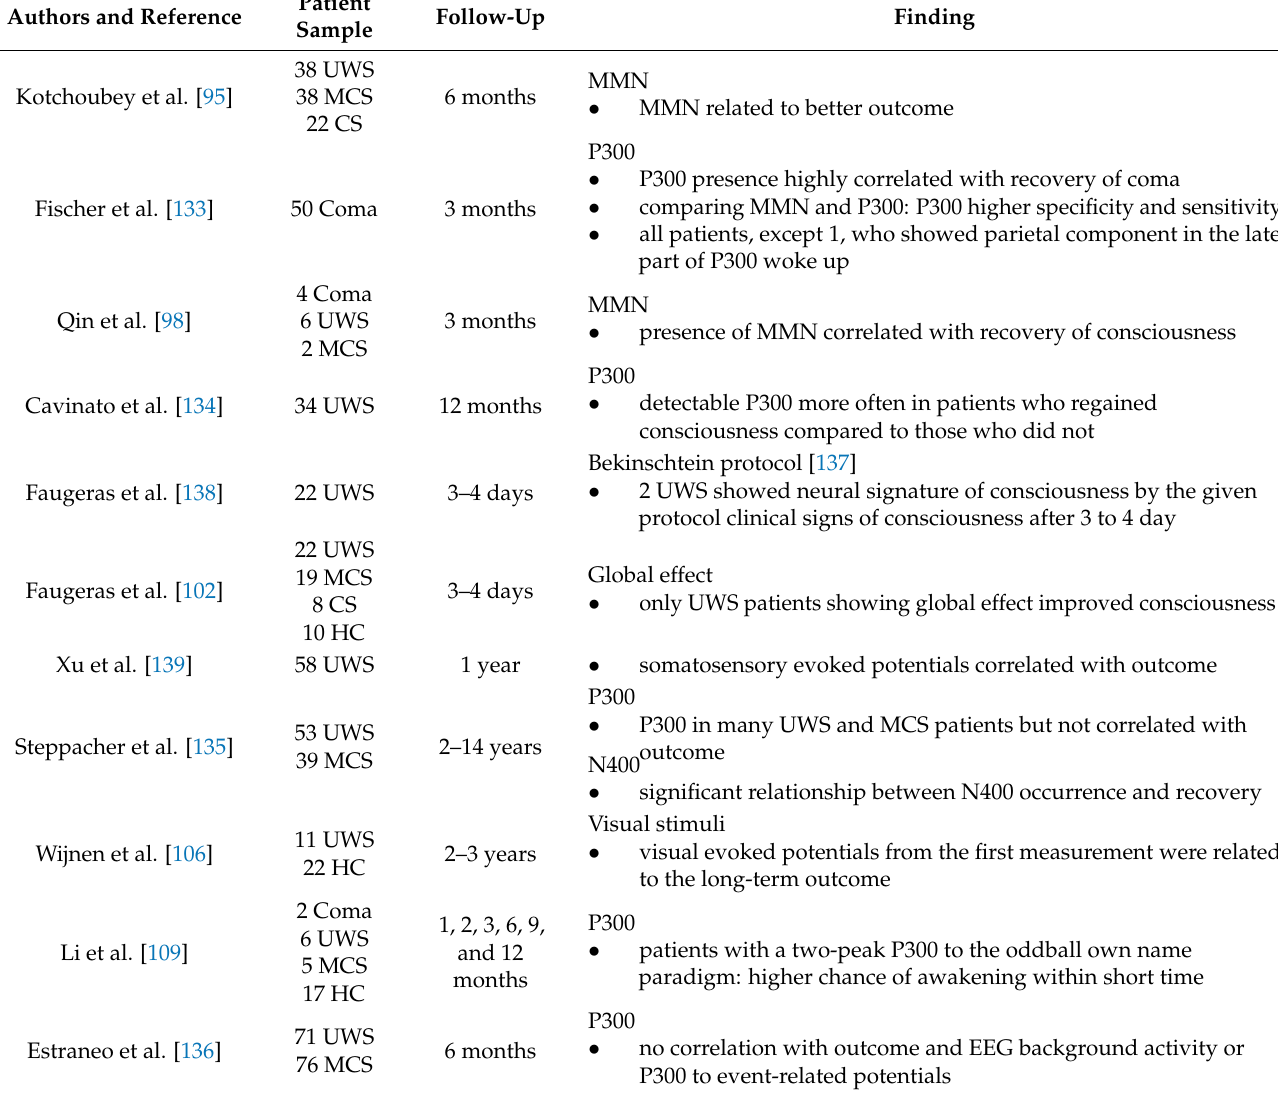
Table 6. Overview of findings for prognosis and evoked potentials; abbreviations can be found in Abbreviation. Authors and